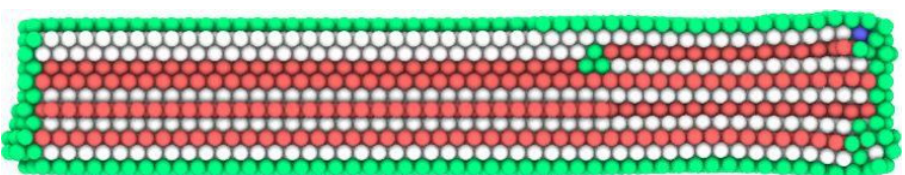
Fig. 19. Outlook of the amorphized nanorod at the time instant 2 ps after the cyclic loading start.  x 0 = 0.5 Å,  =1 THz.